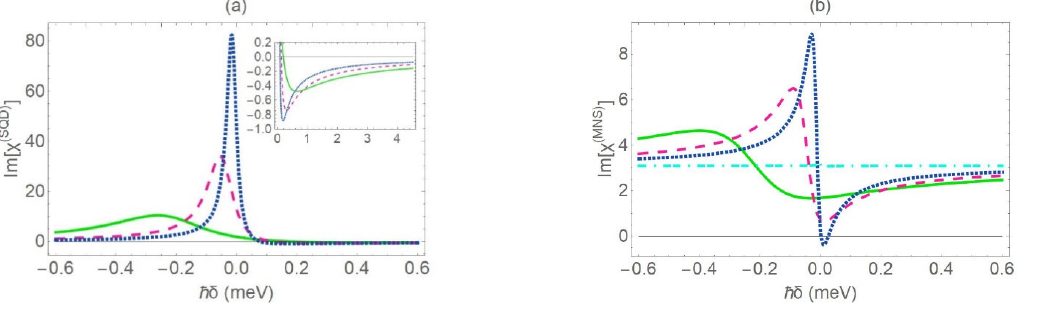
Figure 3. The imaginary part (absorption coefficient) of the linear susceptibility for the SQD ( a ) and the MNS ( b ), as a function of the detuning energy of the probe field ħδ , for various values of the interparticle distance: R = 11.5 nm (green solid curve), 13.5 nm (pink dashed curve), 15.5 nm (blue dotted curve) and 100 nm (turquoise dashed-dotted curve). We also set r 1 = 5 nm, ε c = 1, ε env = 1, r 2 = 7.5 nm, µ = 0.65 q , ε s = 6 and T 2 = 0.3 e